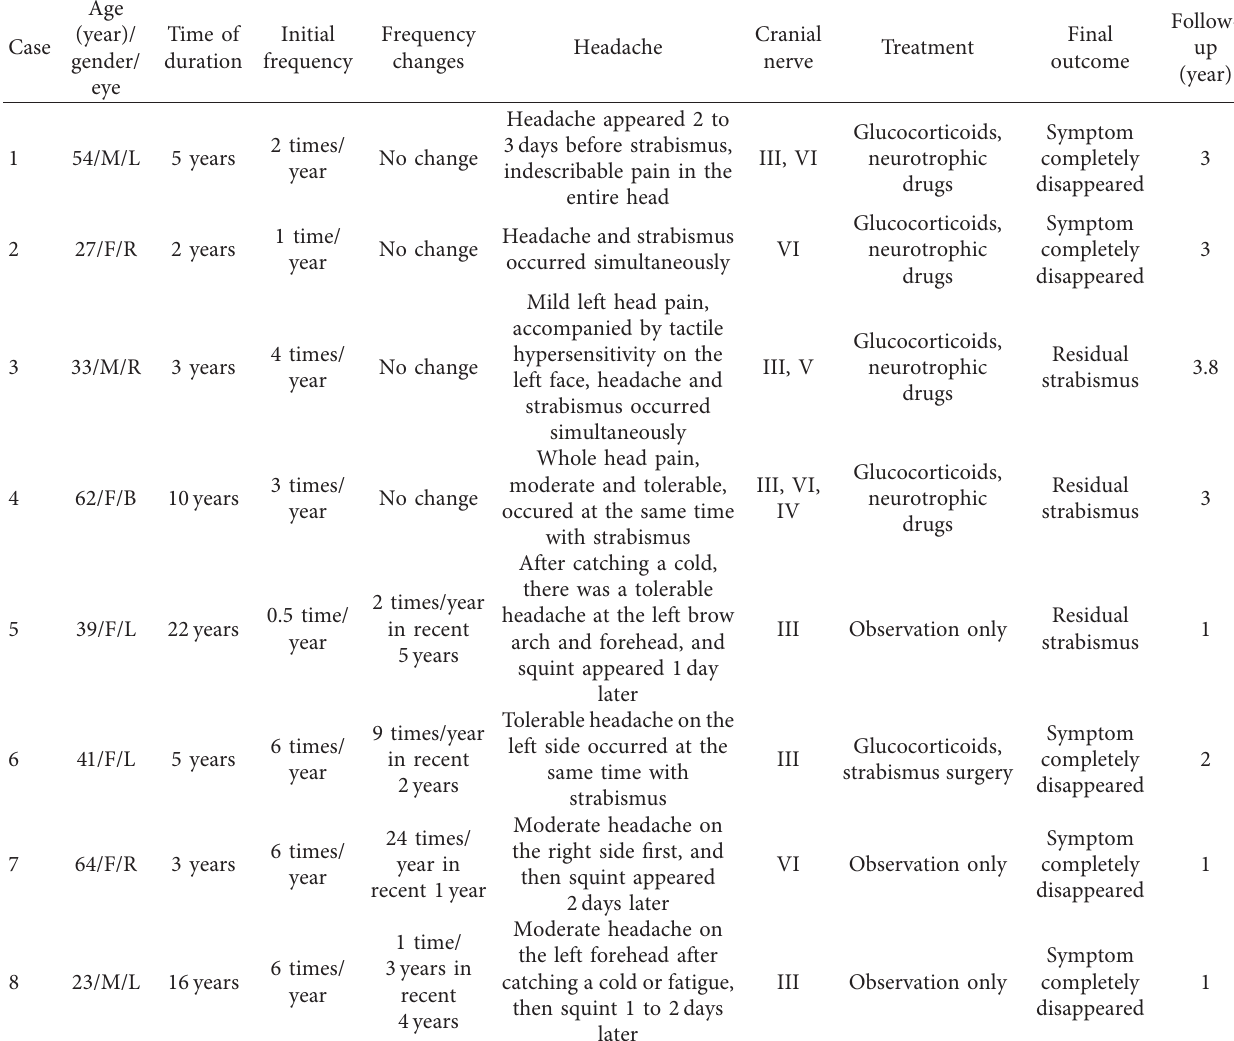
Table 1: The clinical findings and final outcomes of RPON